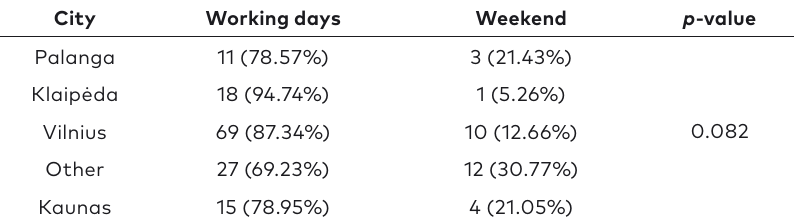
Table 9. The distribution of e-scooter accidents by day and by city in